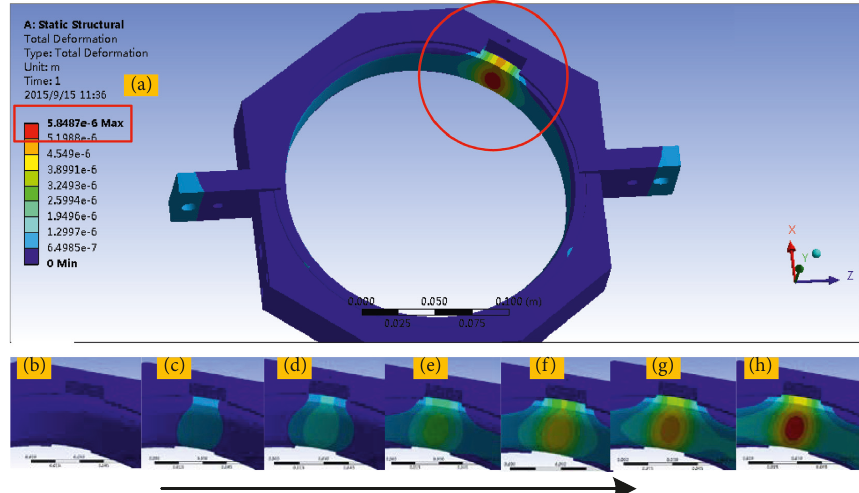
Figure 6: Simulation of the probe unit and